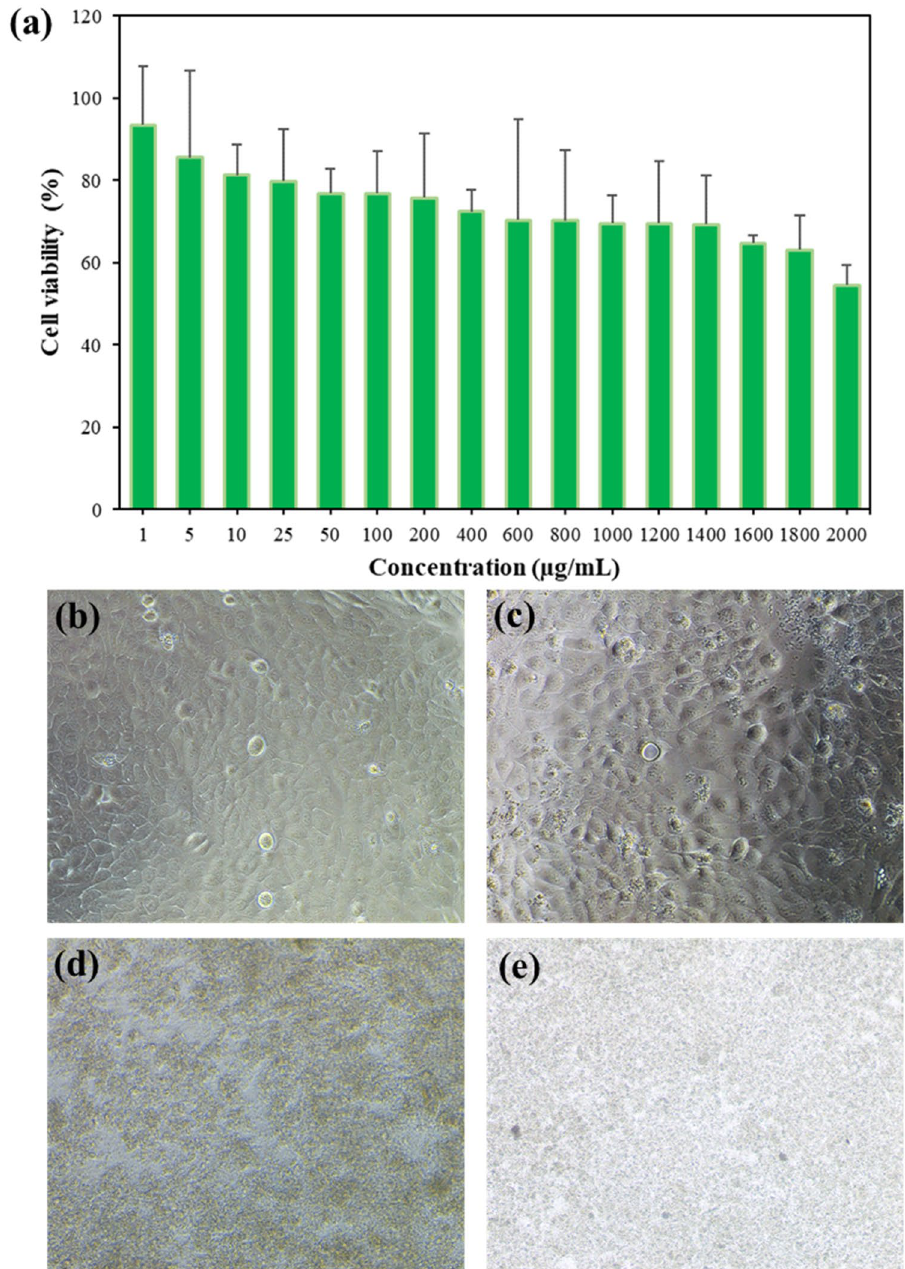
Figure 12. ( a ) Cell viability of HaCaT after incubation with PUD@LO nanoparticles at various concentrations: ( b ) 0 (control), ( c ) 50, ( d ) 1000, and ( e ) 1800